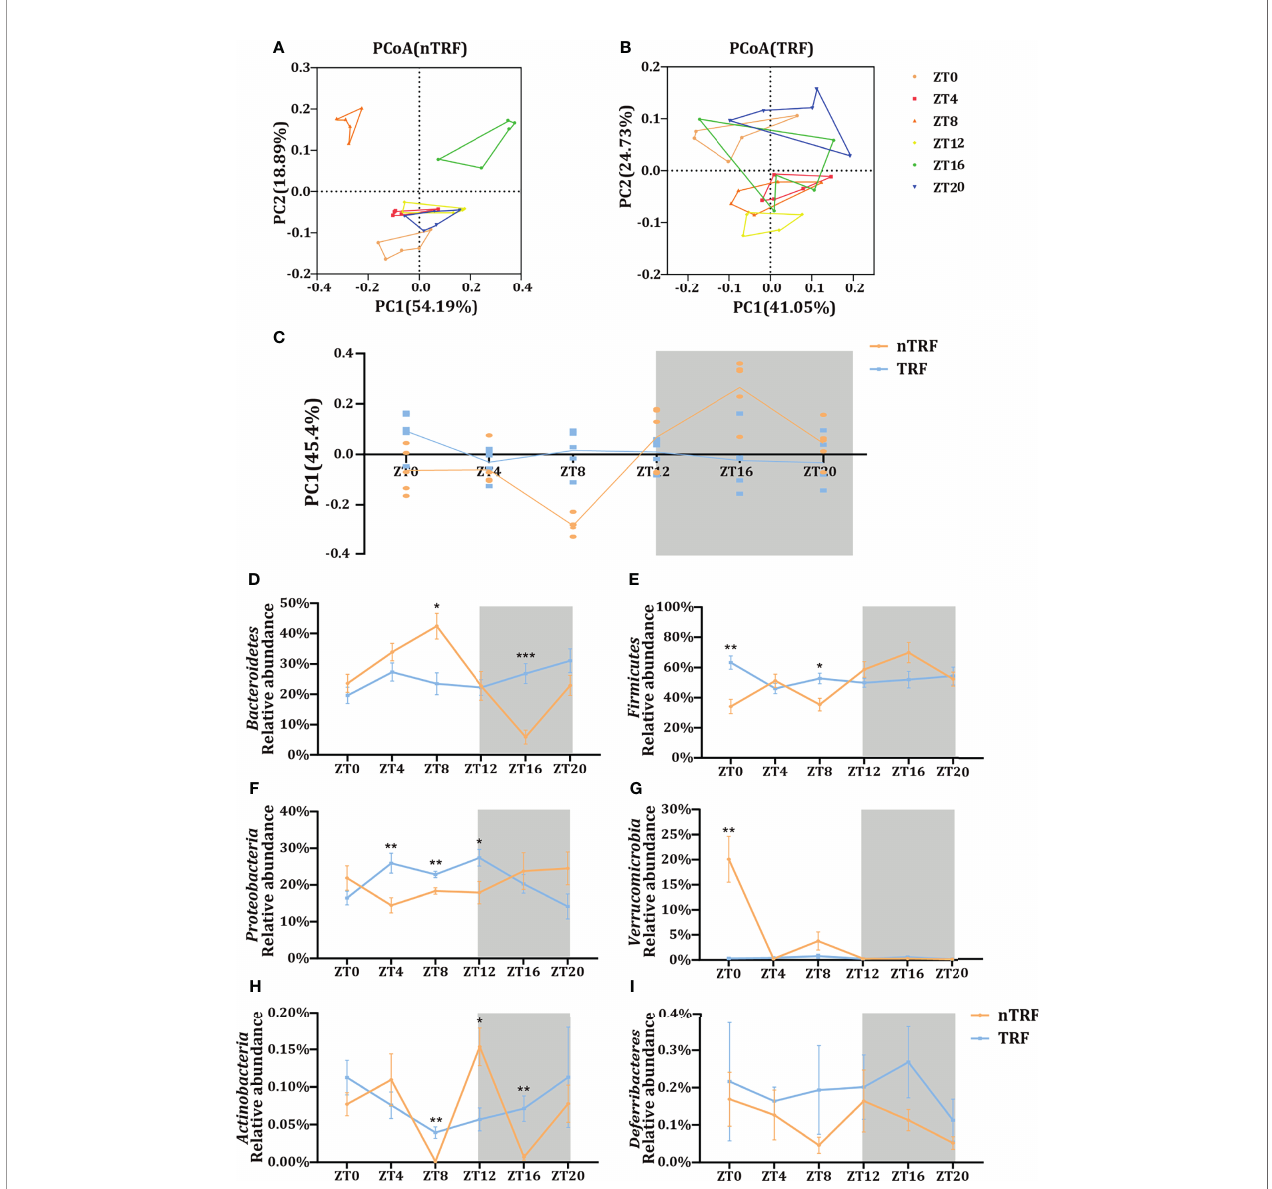
FIGURE 4 | Effects of time-restricted lithogenic diet-feeding (TRF) on the gut microbiota. PCoA (weighted unifrac) analysis of the gut microbiota of mice in the non- TRF (A) and TRF (B) groups. (C) Differences in PC1 (45.4%) of the PCoA in mice from non-TRF and TRF groups. The line represents the mean value for each group. (D – I) Relative abundances of the six most common bacterial taxa in the non-TRF and TRF groups at various ZT. Data are expressed as mean ± SEM (n = 5 mice/ group at each time point). “ * ” means p < 0.05, “ ** ” means p < 0.01, “ *** ” means p <